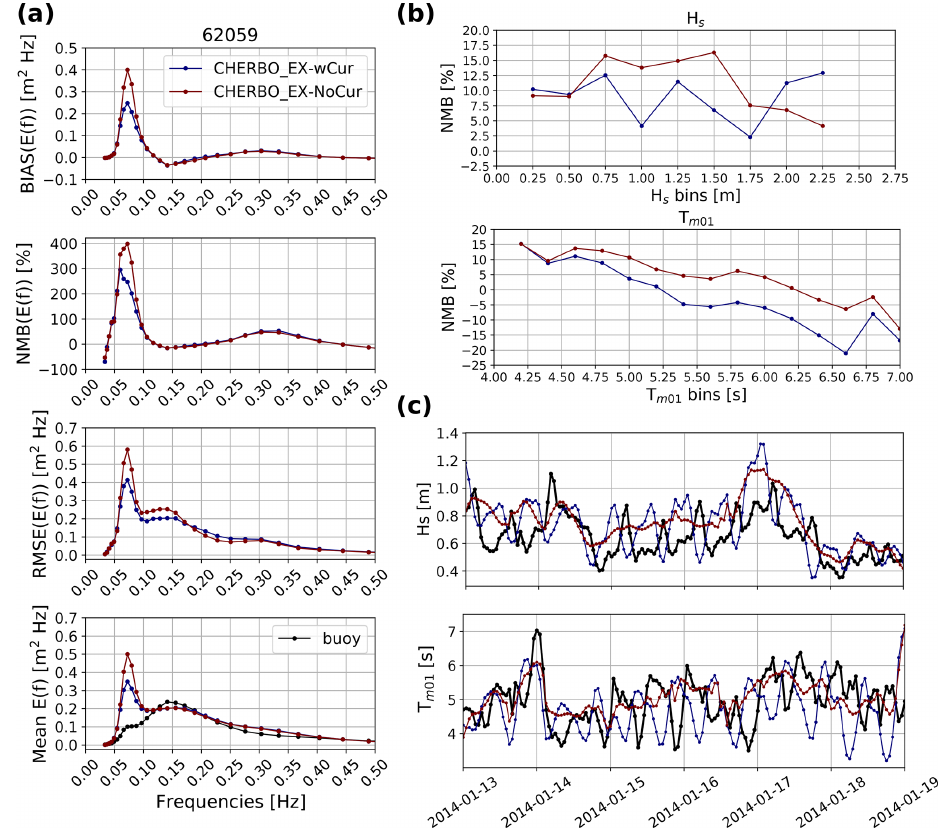
Figure 10. Evaluation of tidal current effects on wave energy distribution (a) : H s and T m01 at buoy 62059 (Cherbourg Exterieur). Wave parameters’ NMB and time series in (b) and (c) , respectively. Results for January 2014. H s bin size is 0.25m; T m01 bin size is 0.2s. Table 3. Tests for spectral directional-resolution effects. All parameters not specified here correspond to test T475. When the directional resolution of the boundary conditions (BCs) is lower than in the mesh, interpolation is applied at the boundary to match the resolution of the nested